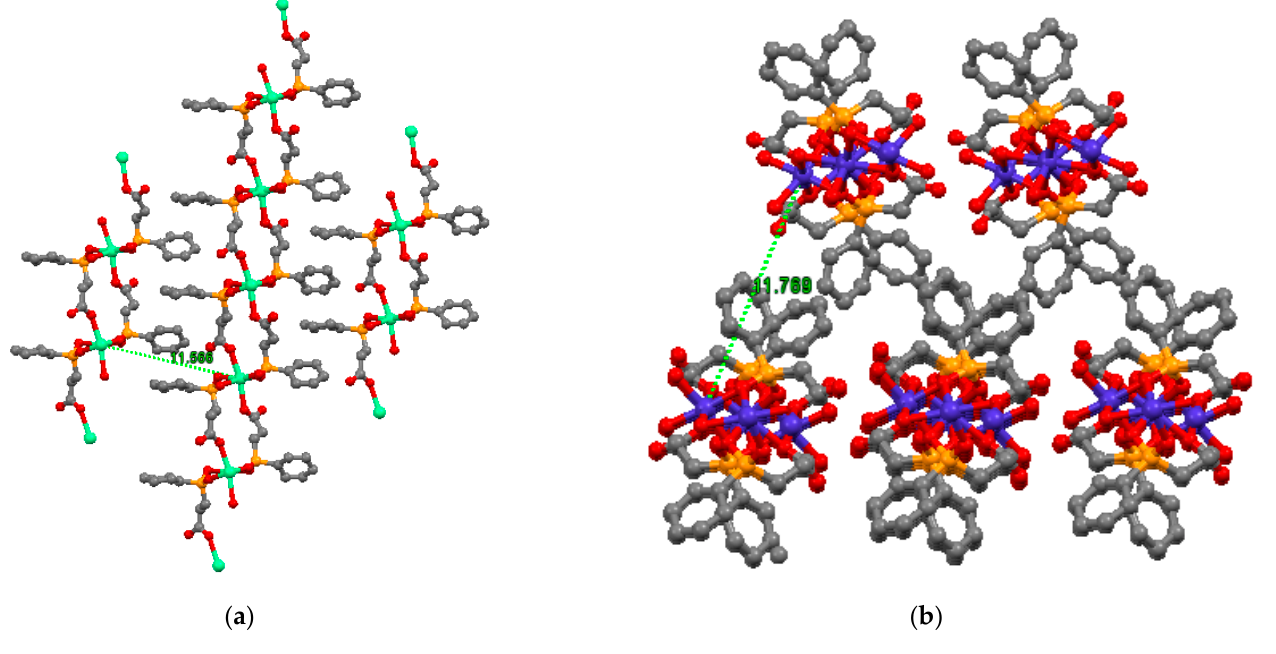
Figure 9. Packing of the CaCEPPA ( a ) and CoCEPPA ( b ).